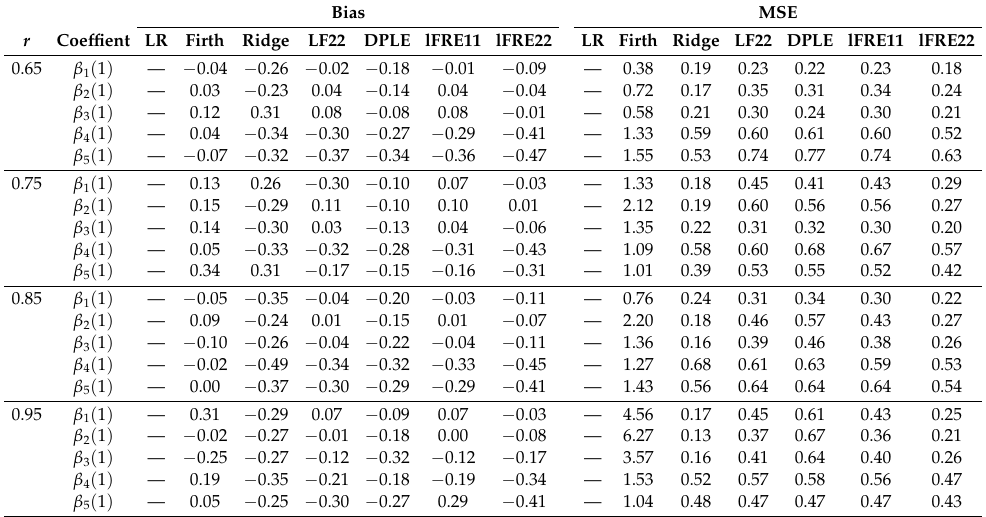
Table 3. Bias and MSE for all explanatory variables (omitting the intercept) for correlation coefficient